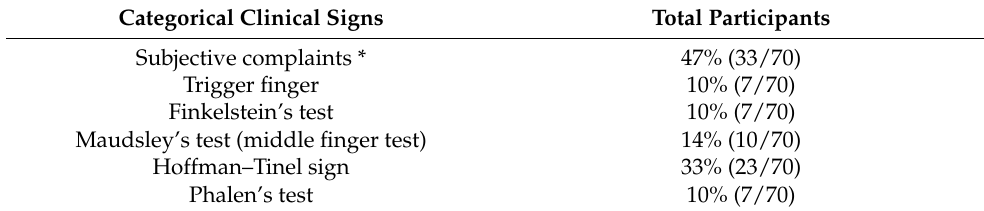
Table 3. Measured categorical clinical